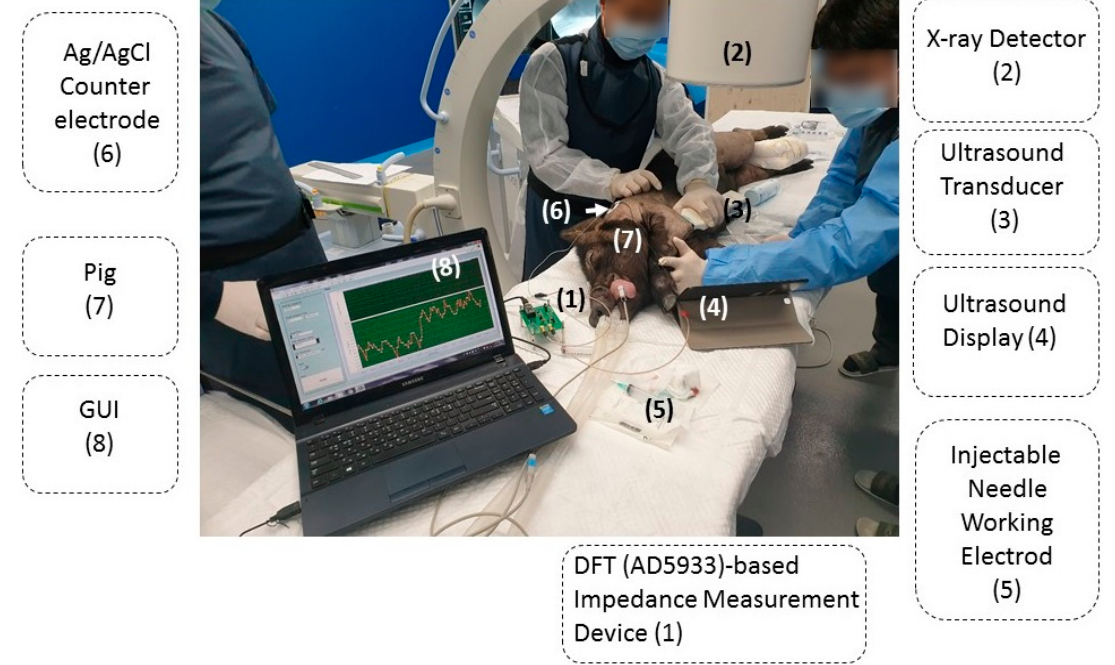
Figure 2. Experimental setup for injecting a drug into the intra-articular space of the experimental animal with an impedance measurement system (1), X-ray detector (2), ultrasound transducer (3), ultrasound display (4), injectable needle working electrode (5), Ag / AgCl counter electrode (6), Pig (7), and LabVIEW GUI (8).